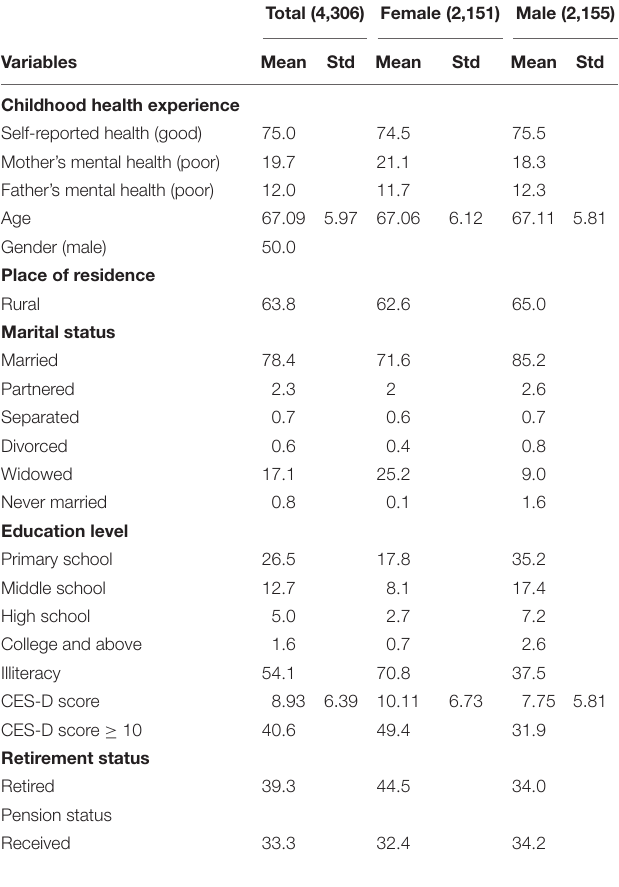
TABLE 1 | Descriptive characteristics of the